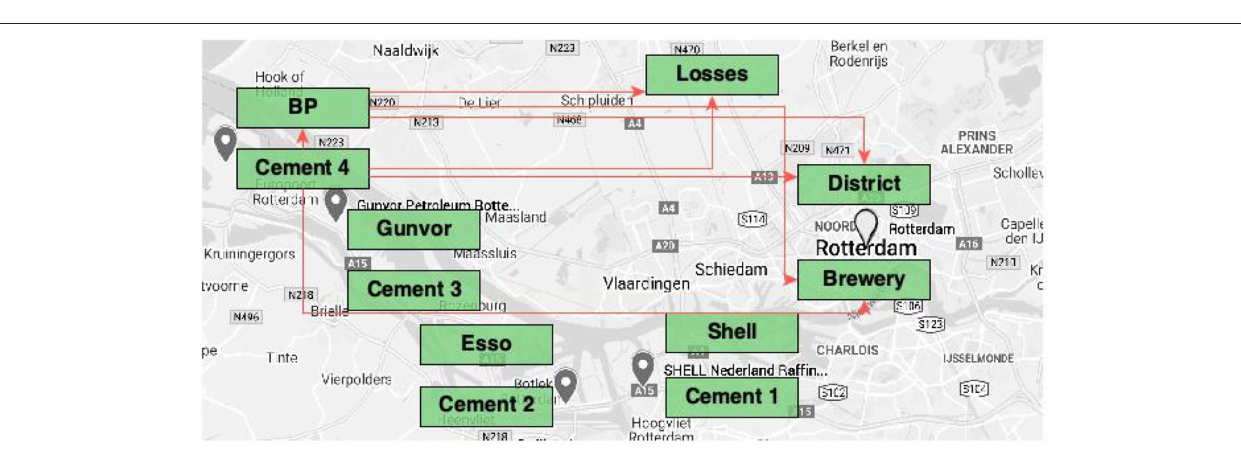
FIGURE 9 | Schematic description of brewery and cement plants interaction with DHC